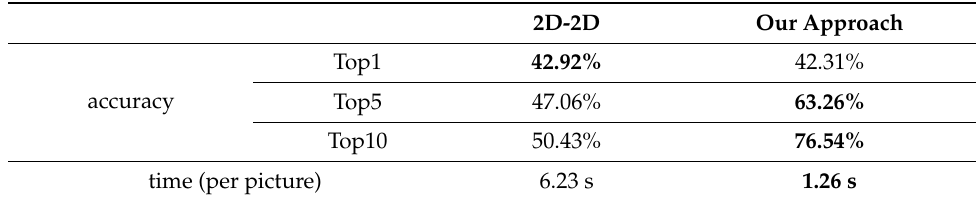
Figure 10. Visual comparison of the traditional 2D–2D method and our method. ( a ) represents ureteroscopic images, ( b ) represents the matching results of the traditional method, and ( c ) represents the matching results of our method. Our method based on the depth map showed a better performance. Table 4. A quantitative comparison of CT-video matching accuracy and time performance by the different